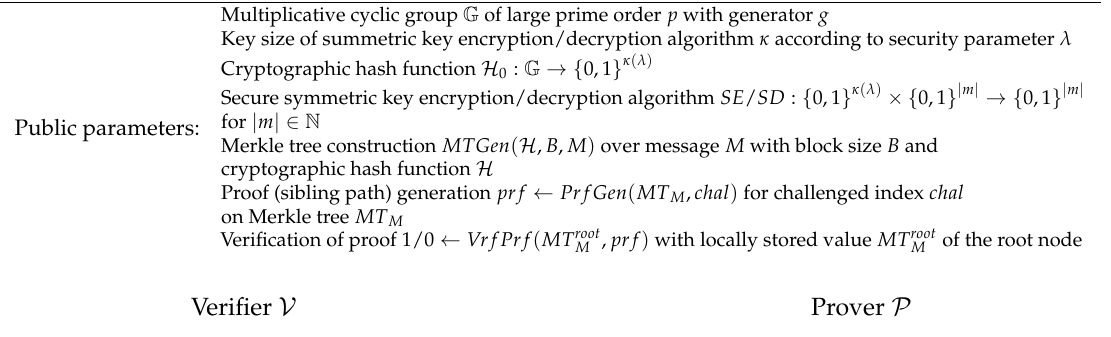
Algorithm 2 Merkle tree-based online authentication with encrypted